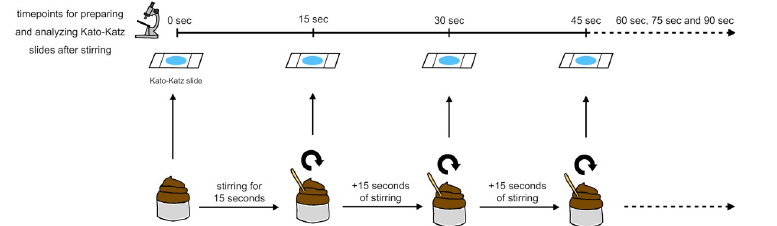
Fig 3. Procedure of the homogenizing